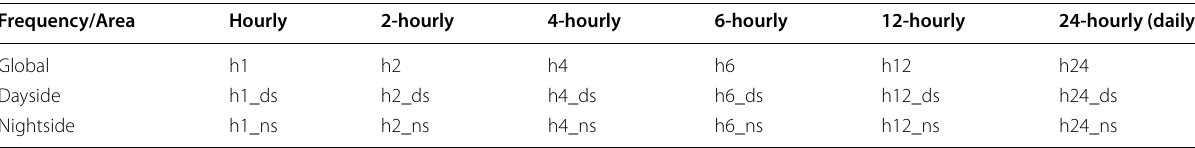
Table 1 Cases of synthetic temperature observations for observing system simulation experiments